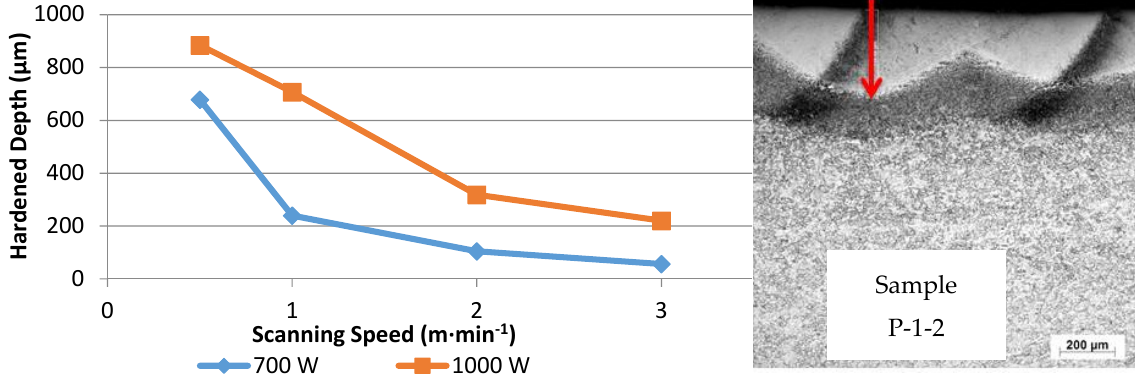
Figure 10. Variations in the depth of hardened regions with respect to laser power and laser scanning speed.